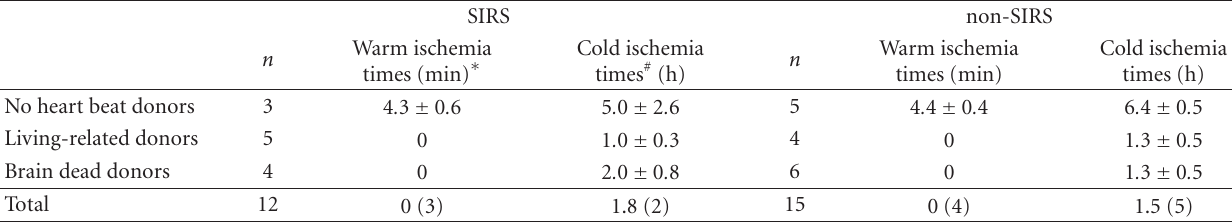
Table 2: Postoperative SIRS in patients receiving di ff erent categories of transplant.